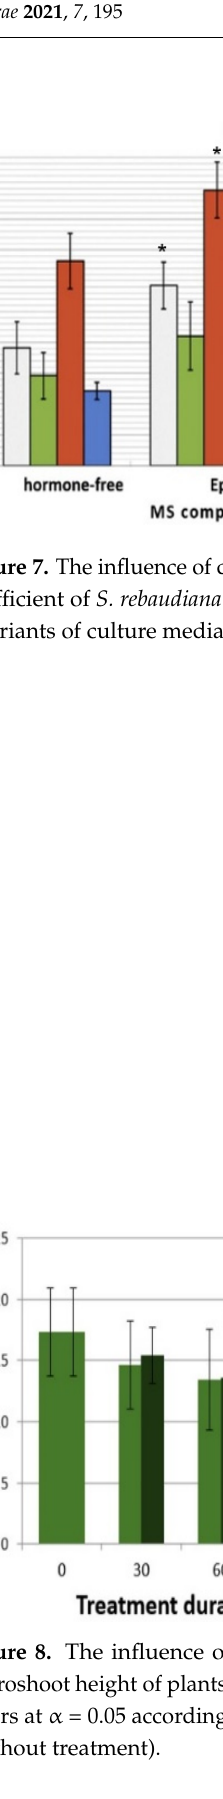
9 of 15 Figure 6. ( a ) Main shoot heights and ( b ) multiplication coefficients of S. rebaudiana microshoots in in vitro cultures under different spectra of monochrome LED lighting. Means ± standard errors at α = 0.05 according to the ANOVA test ( n = 60). *-variants that had significant differences between control treatments (white light). 3.2.4. The Combined Effect of Physical and PGRs Factors on the Morphogenesis of S. rebaudiana Microshoots Culture In Vitro Monochrome Light Treatment in Combination with PGRs under In Vitro Conditions To study the combined effect of physical (monochrome light) and chemical (PGRs) factors on the morphological characteristics of S. rebaudiana microshoots in vitro, an ex- tended experiment was conducted. We found that all variants of culture media, under red LED treatment, promoted intensive shoot growth, which occurred due to internode ex- tension. A more obvious visible effect was observed in the variant supplemented with 0.1 mg L − 1 Epin in combination with 0.5 mg L − 1 IAA in culture on MS media (Figure 7a, Epin). In culture media with 1.0 mg L − 1 BAP and IAA (Figure 7a, BAP), red light also enhanced the biometric indicators of S. rebaudiana microshoot cultures compared with controls (MS media without PGRs). It was experimentally established that the multiplication coefficient was controlled by both PGRs and the spectral composition of provided light sources. The biggest differ- ences were obtained on culture media supplemented with BAP (Figure 7b, BAP). In the case of light from the white and green spectra, the multiplication coefficient decreased to